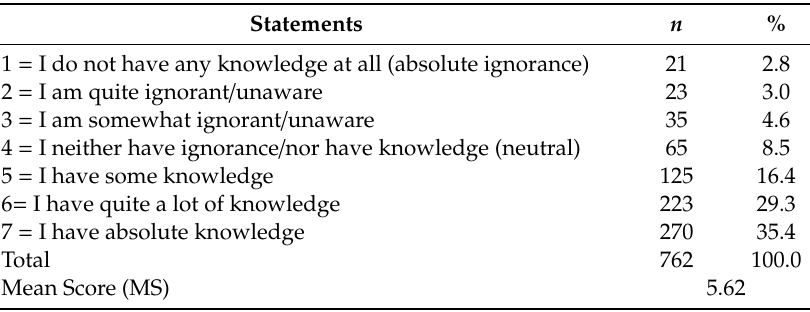
Table 2. Self-assessed (overall) knowledge of COVID-19